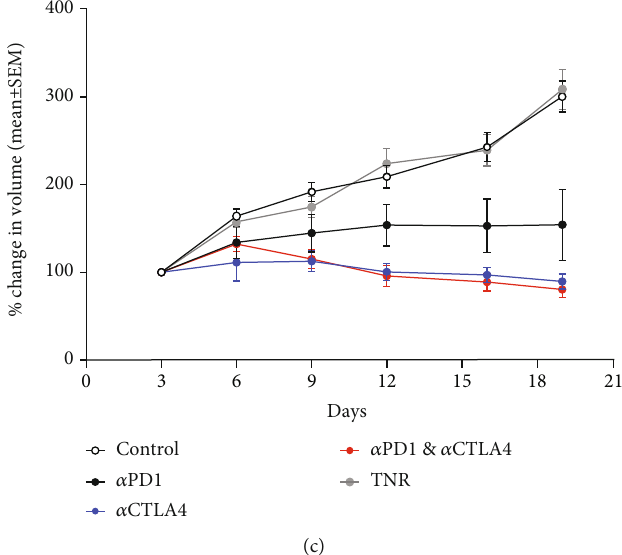
Figure 1: Graph displaying tumour volumes in response to administration of ICI therapy. Mice ( n = 10 − 15 ) were i.p. treated with control IgG, α PD1 monotherapy, α CTLA4 monotherapy, or combined α PD1 + α CTLA4 on days 6, 9, and 12 posttumour implantation. (a) Individual HEPA 1-6 tumour volumes posttumour implantation. (b) Average tumour volume and (c) % change in tumour volume of HEPA 1-6 tumour-bearing mice on days 3, 6, 9, 12, 16, and 19 posttumour implantation. Data are shown postseparation of TNR group and represented as mean ± S : D : (TNR: treated